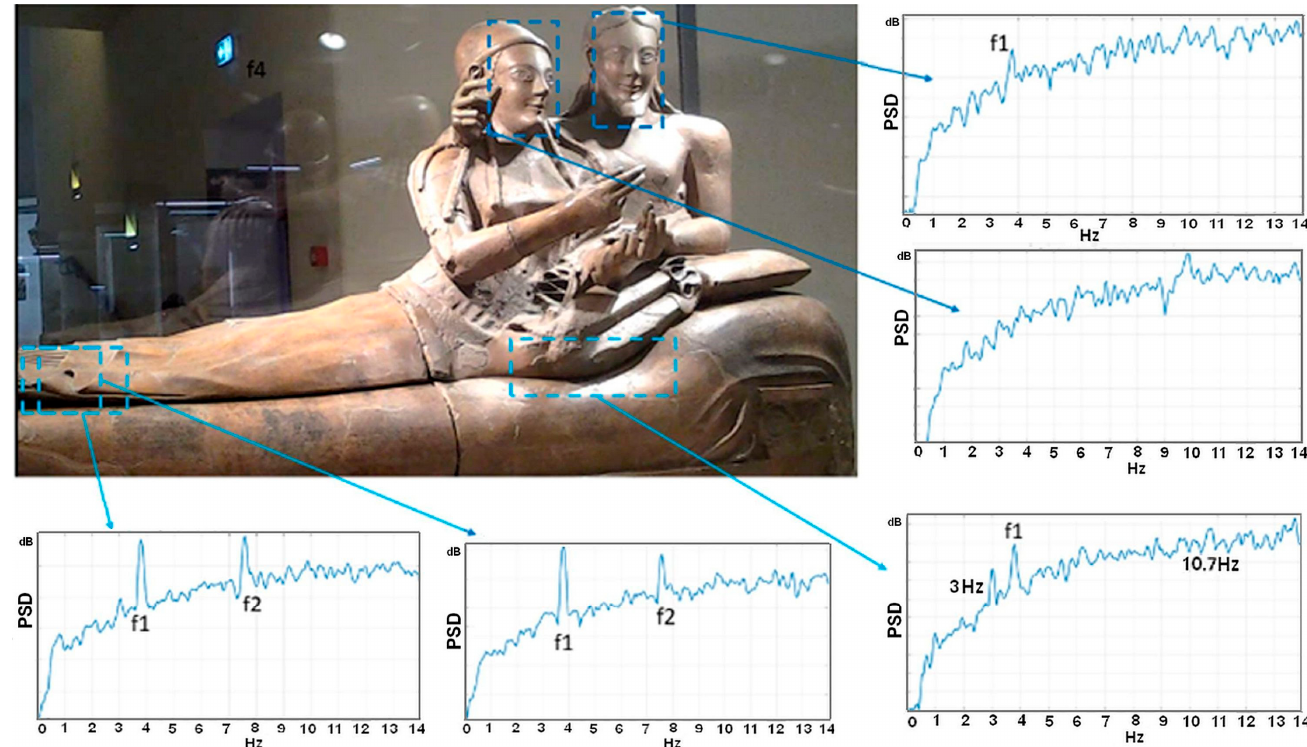
Figure 20. Frequency response analysis of various ROIs (blue dotted areas) on the Sarcophagus of the Spouses.